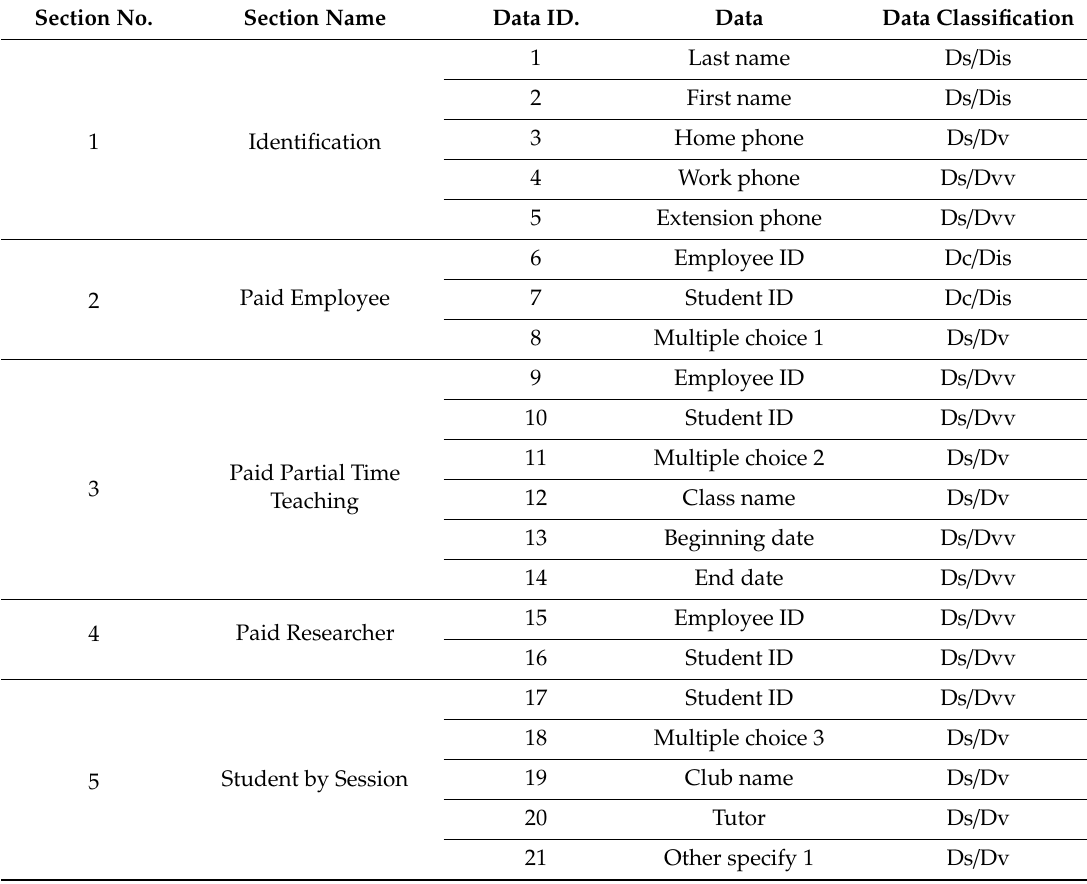
Table 1. (Form F1–00). Structure and du classification according to their characteristics. Ds = simple data; Dc = composite data; Dia = indispensable data for authorization; Dis = indispensable data for the system; Dv = simple verification data; and Dvv = double verification data. Section